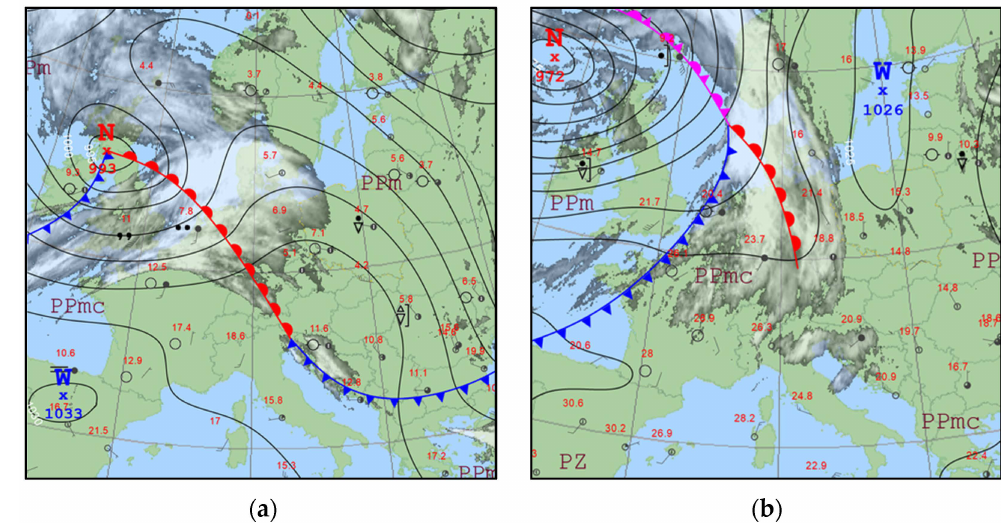
Figure 2. Synoptic maps from IMGW-PIB for the situations of: ( a ) 24 February 2020; and ( b ) 22 May 2020 (warm